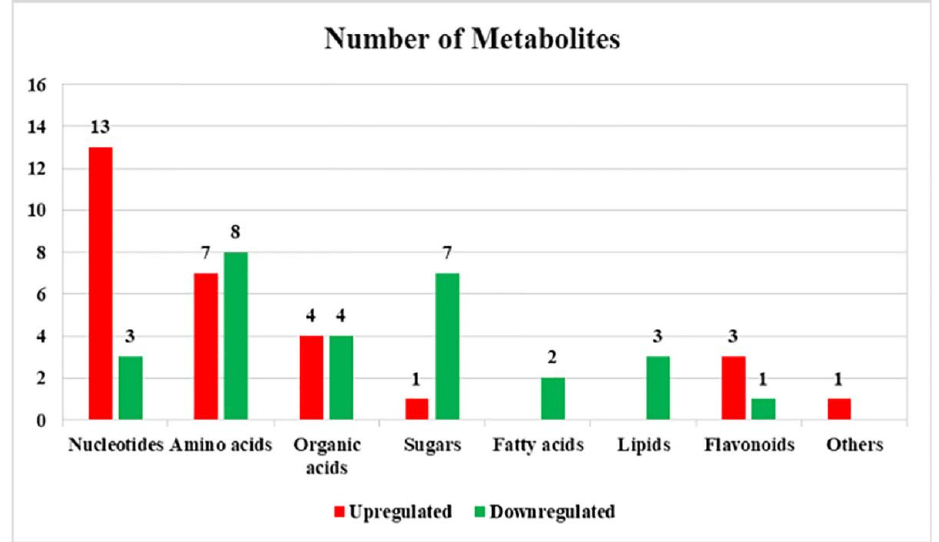
Figure 2. The numbers of upregulated and downregulated differential metabolites in L. chinensis under alkali stress.